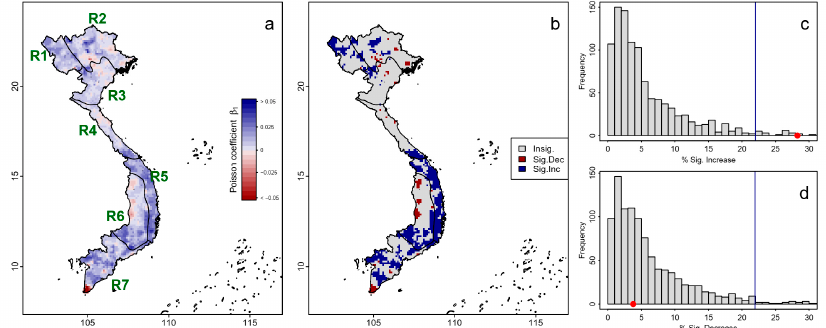
Figure 6. Changes in the frequency of heavy precipitation across Vietnam from 1980 to 2010. ( a ) Poisson regression coefficient β 1 across seven climate regions (polygons bounded by black lines). ( b ) The significance of changes: blue (red) cells indicate locations associated with statistically significant increasing (decreasing) trends at the 5 % level. ( c ) The null-hypothesis distribution (grey histogram) and the observed value (red dot) of the percentage of stations showing significant increasing trends. ( d ) Similar to ( c ), but for significant decreasing trends. The blue lines in ( c ) and ( d ) represent the 97.5th percentile of the null-hypothesis distribution.